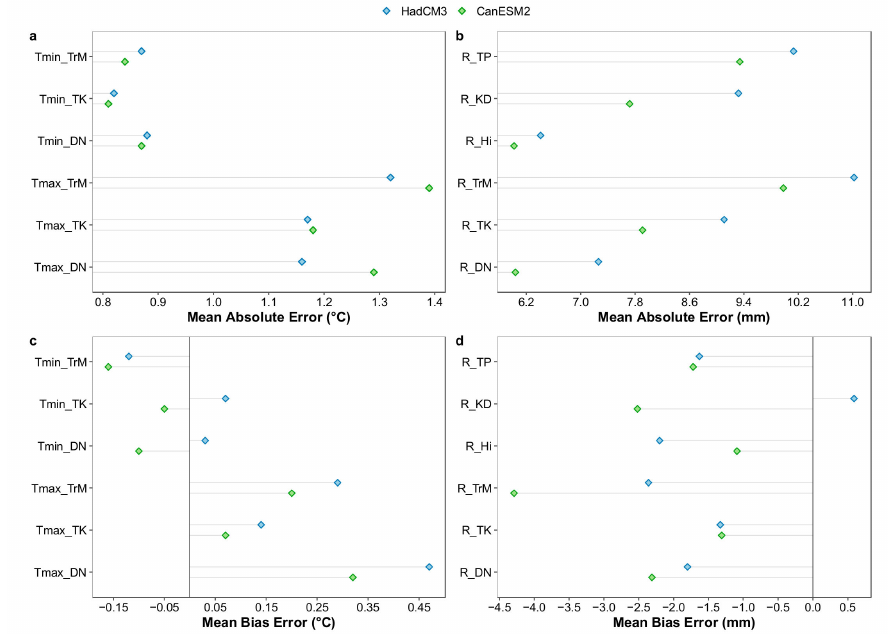
Figure 4. The values of MAE and MBE between observed and predicted daily series during validation. Tmax, Tmin, and R stand for maximum and minimum temperature and rainfall.